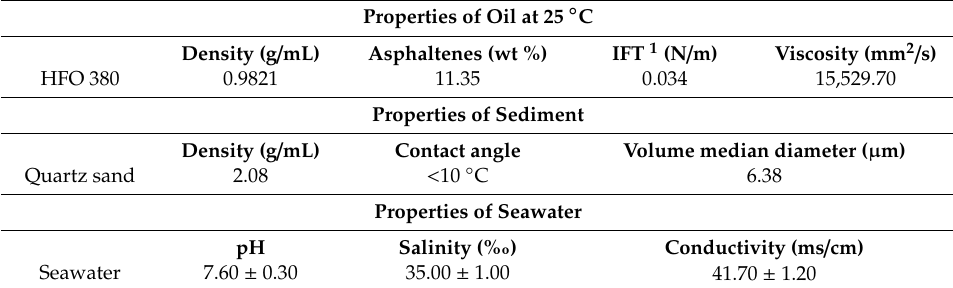
Table 1. Physicochemical characteristics of heavy fuel oil 380 (HFO 380), sediment, and seawater.